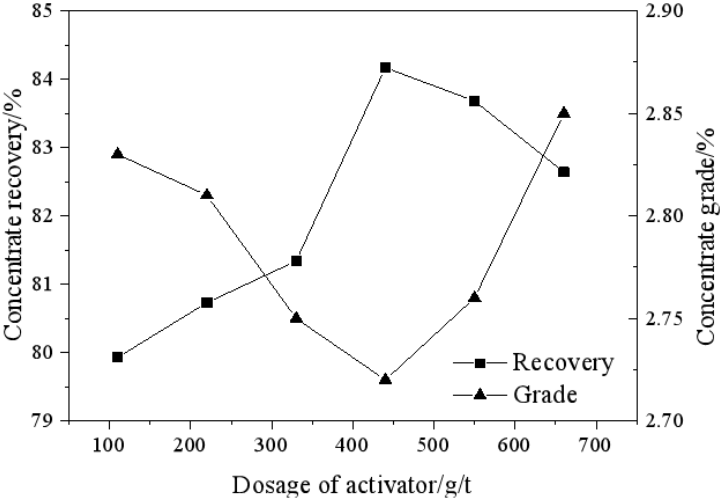
Figure 8. Influences of the amine-ammonium combination activating dosage of the copper oxide flotation index.